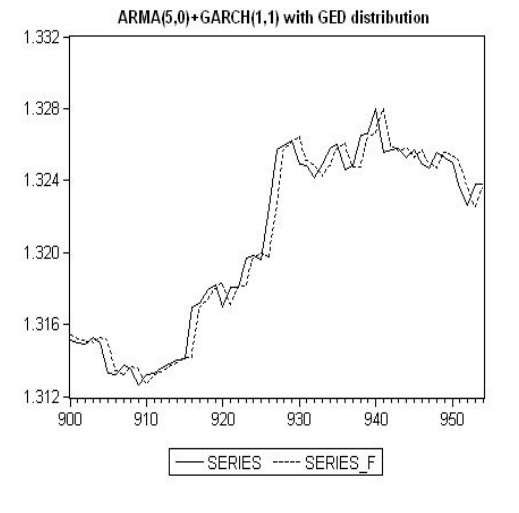
Fig. 4. Actual (solid) and forecast (dotted) values of the VUB fund.